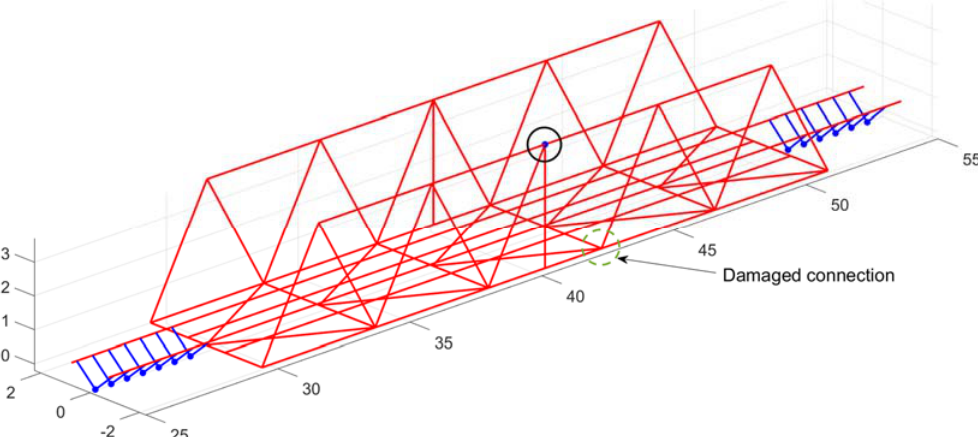
Figure 2. Total damage affecting the side wall diagonal chord. The blue points represent: inside the bridge, the mass of the damaged element concentrated in a specific node, encircled in black, while outside, they represent sleepers masses. The blue lines outside the bridge, identify rail pad connections, modelled by means of springs.